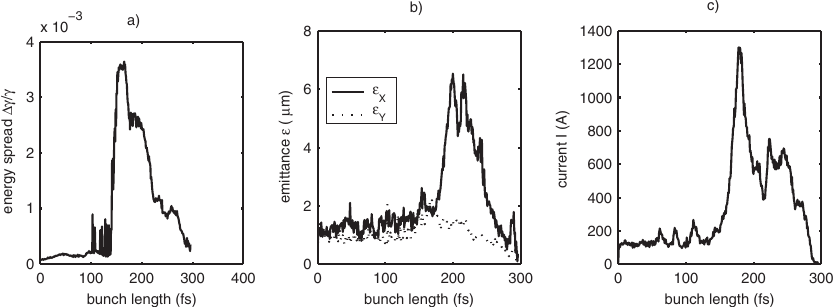
FIG. 5. Sliced energy spread (a), emittance (b), and current (c) just before the undulator section.